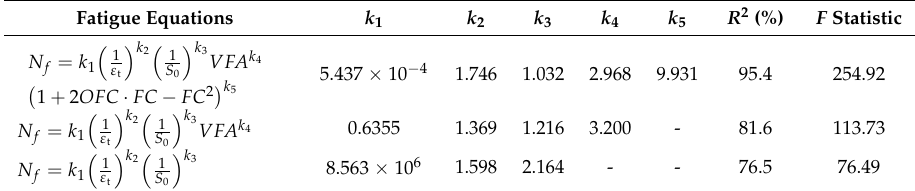
Table 6. Regression coefficients and statistical parameters of fatigue equations. Fatigue Equations k 1 k 2 k 3 k 4 k 5 R 2 (%) F